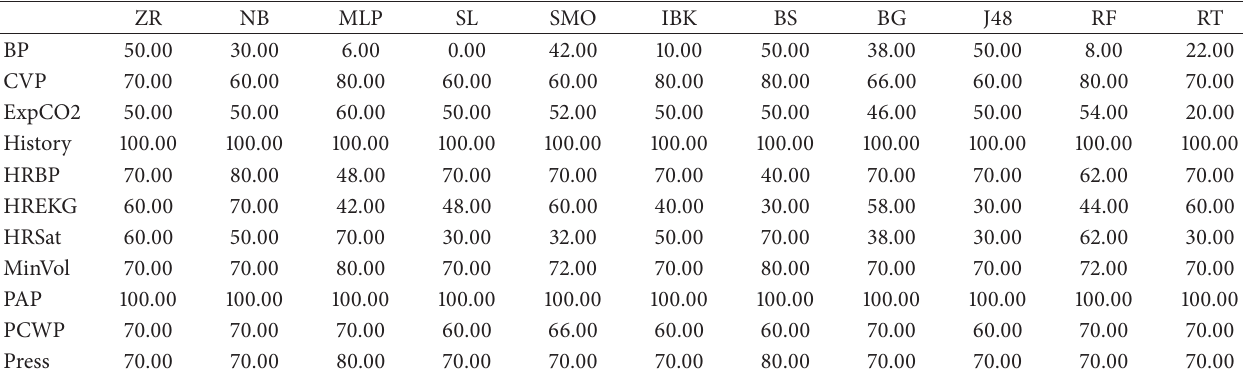
Table 4: Classification accuracies with datasets having 10 samples (%).